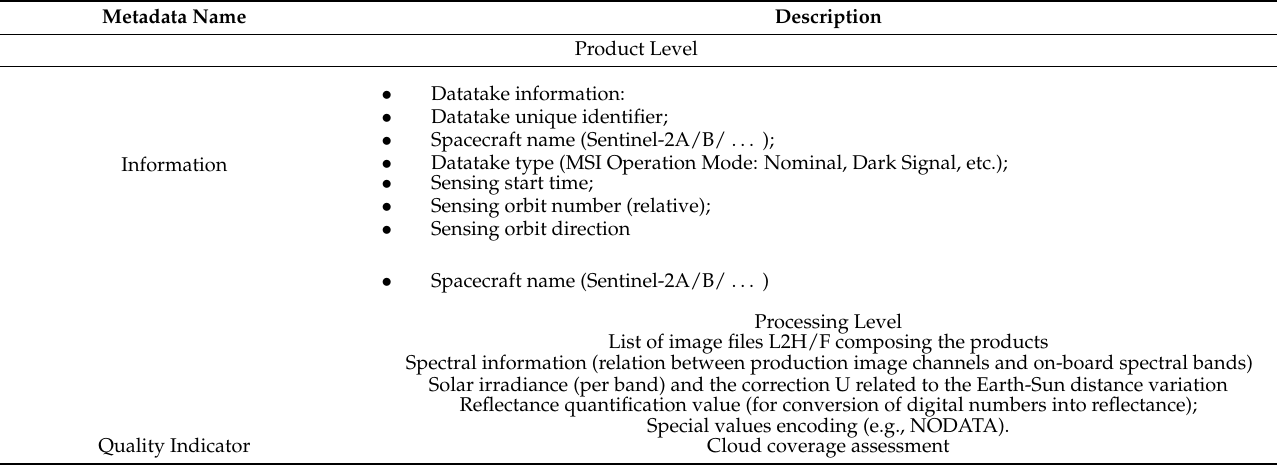
Table A3. Sen2Like metadata embedded within the L2F and L2H product